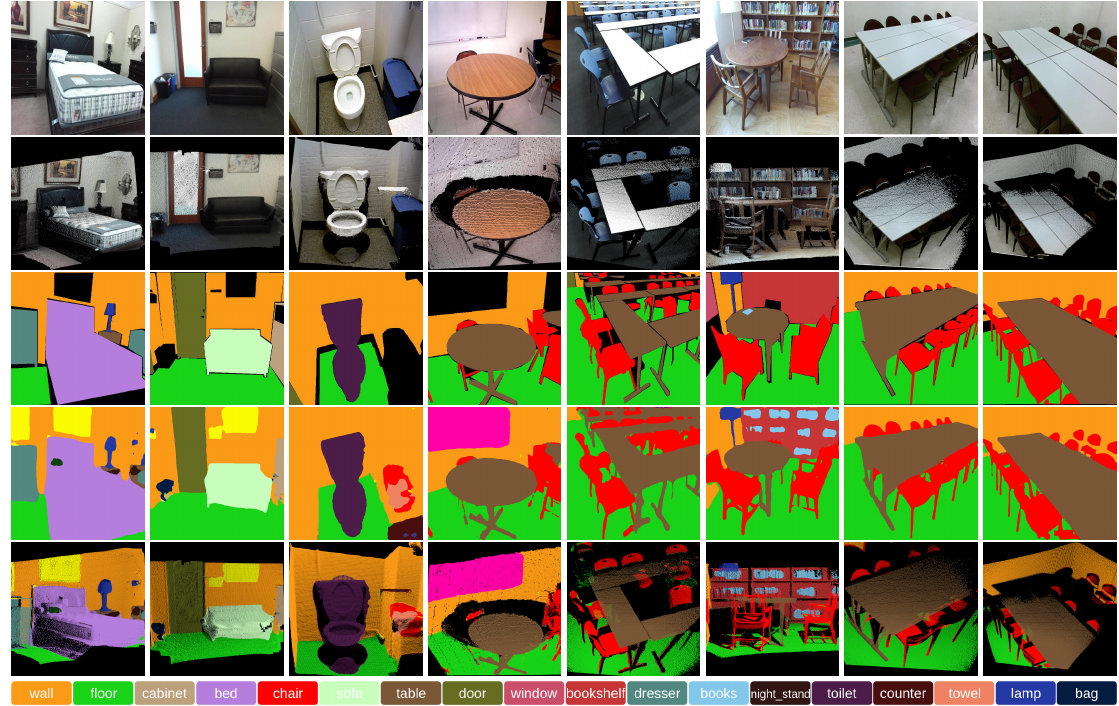
Figure 6. Qualitative results (best viewed in colour) for the Pixel-Voxel network on the SUN RGB-D dataset. For different scenes in each row, the following images are displayed: RGB image (Row 1), 3D point cloud (Row 2), ground truth image (Row 3), 2D semantic image (Row 4) and 3D semantic point cloud (Row 5). The Pixel-Voxel network produces results with accurate boundary shape such as the shape of the bed, toilet and especially the legs of the